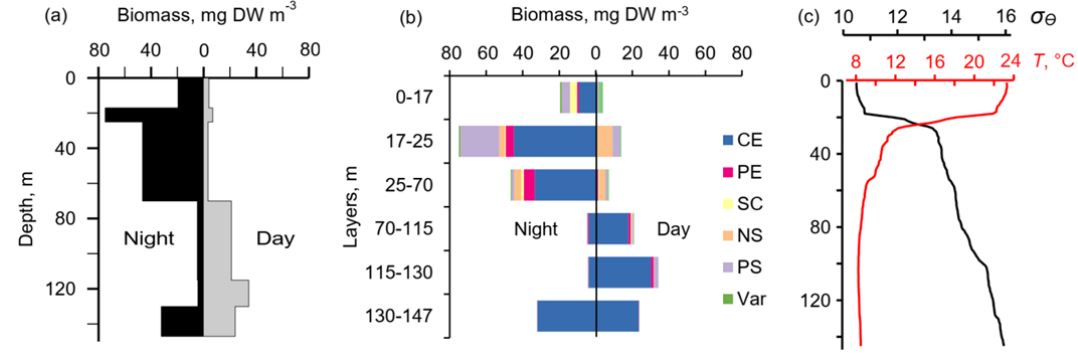
Figure 10. The day–night vertical distribution of (a) total mesozooplankton biomass, (b) zooplankton composition, and (c) temperature ( T ) and density ( σ (cid:50) ) near the mooring site on 1 July (13:30–14:30) and 2 July (02:30–03:30) 2014. Temperature and density profiles (c) indicate the selection of sampling strata. CE – Calanus euxinus ; PE – Pseudocalanus elongatus ; SC – small crustaceans; NS – Noctiluca scintillans ; PE – Parasagitta setosa ; Var – varia.